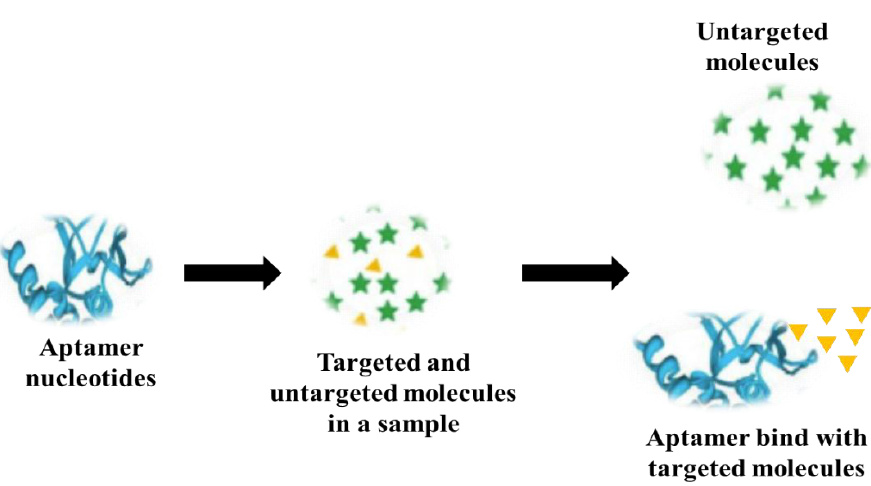
Figure 4. A flow diagram showing an aptamer-based norovirus detection approach.